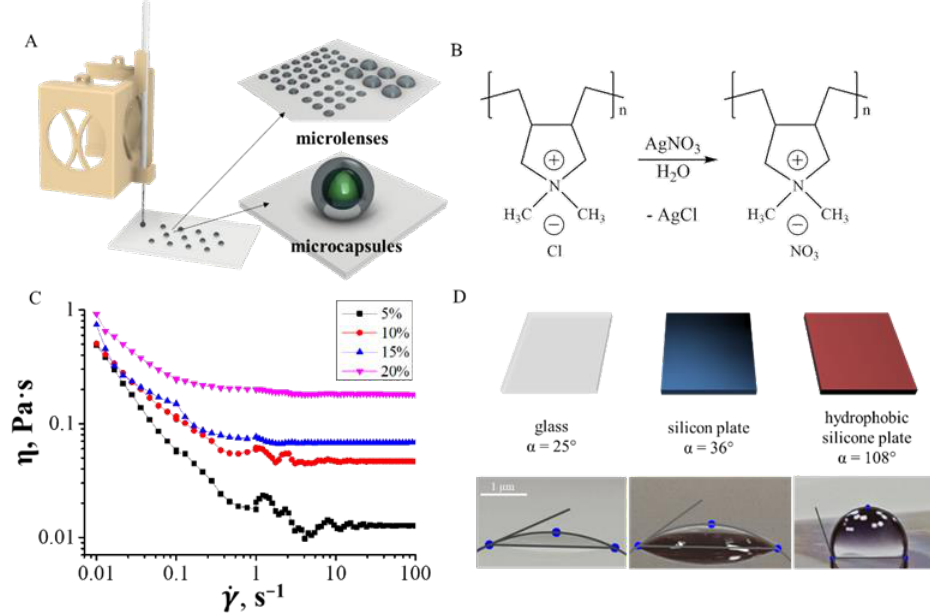
Figure 4. Scheme of droplet printing, ink parameters and substrate options for microlens printing. Ink parameters for droplet printing. ( A ) a schematic representation of the principle of droplet printing and possible applications of printed structures, ( B ) a scheme for the synthesis of an ionic polymer PIL-NO 3 , ( C ) variation in shear viscosity plotted as a function of the shear rate for inks with different concentrations PIL-NO 3 (5, 10, 15 and 20 wt%); ( D ) top: scheme of used substrates, and bottom: contact wetting angle with glass, silicon and hydrophobized silicon.